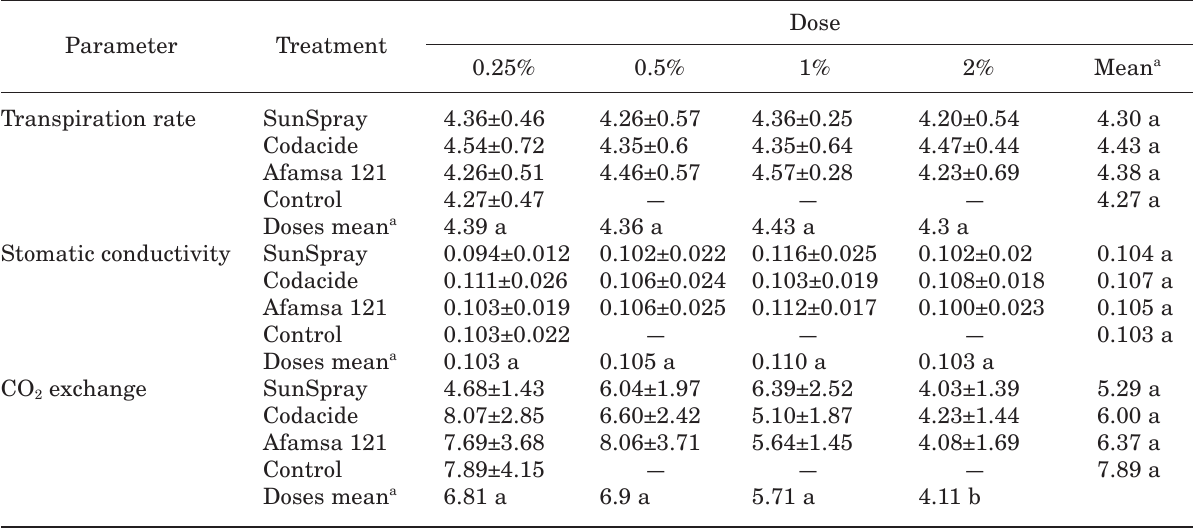
Table 2. Mean and standard deviations of the parameters analysed in the field phytotoxicity assay, one week after the sixth treatment. Transpiration rate in mol/(m 2 ·seg), stomatic conductivity in mol/(m·seg) and CO mmol/(m 2